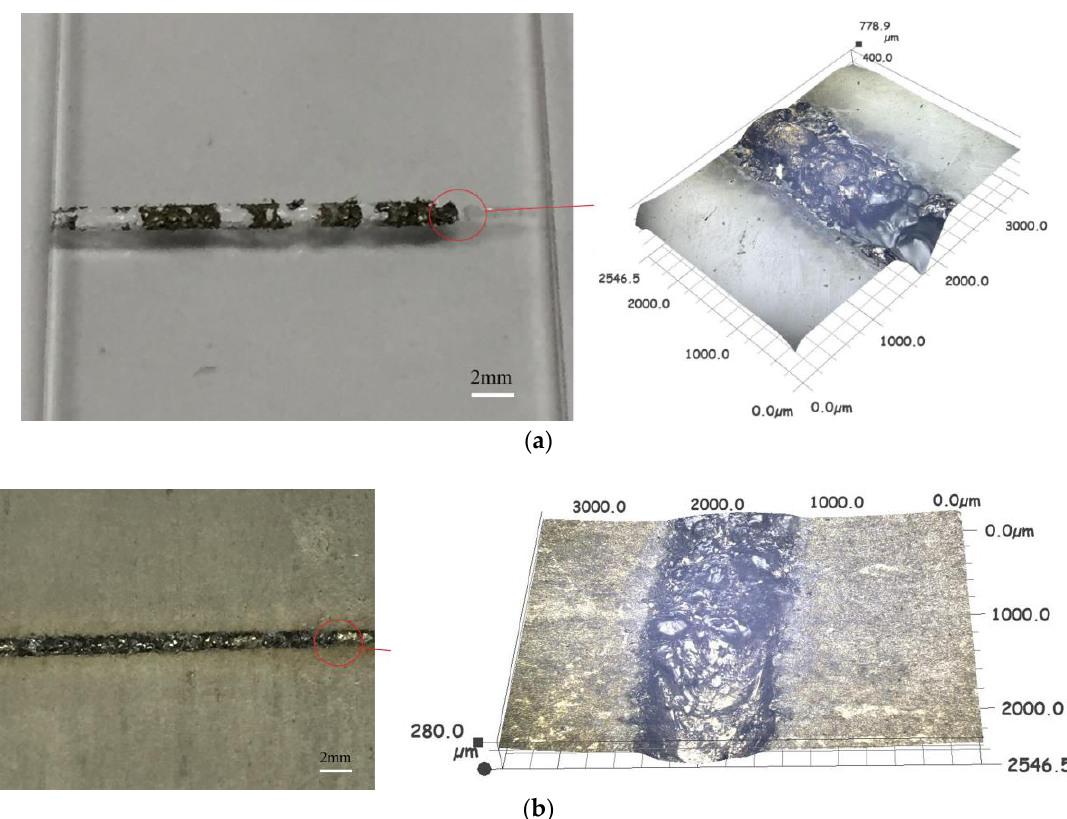
Figure 5. Micrographs of titanium alloy and high-borate borosilicate glass welds after tensile test: ( a ) glass and ( b ) titanium alloy.